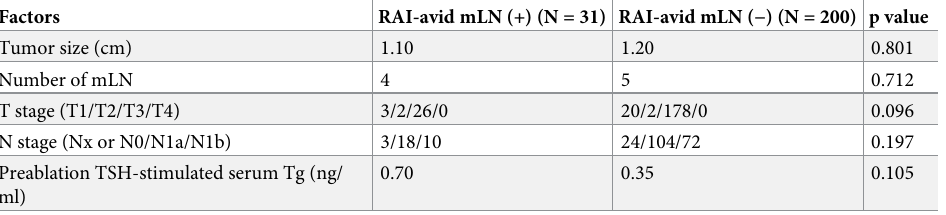
Data are presented as number or median. TSH: thyroid-stimulating hormone, Tg: thyroglobulin, mLN: metastatic lymph node; RAI, radioactive